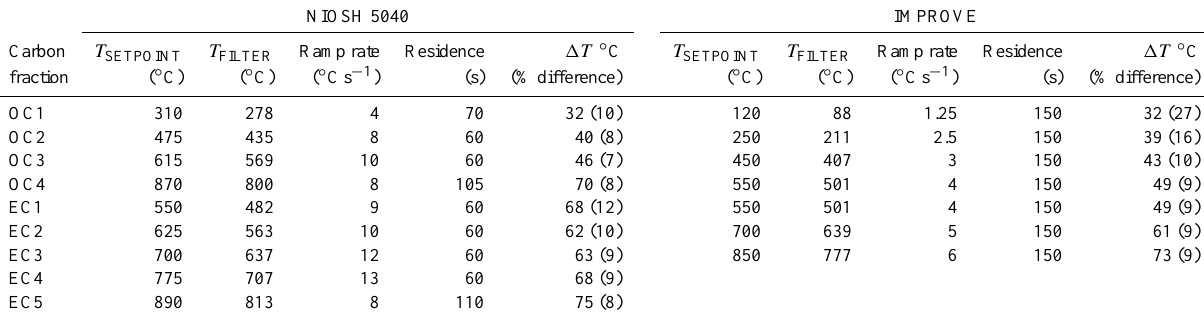
Table 2. Filter temperatures measured before calibration for NIOSH 5040 and IMPROVE